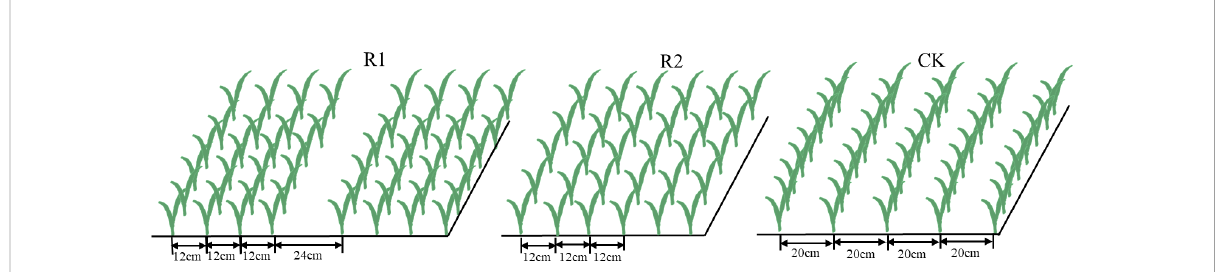
FIGURE 1 Illustration of different row spacings. CK, uniform planting (20 cm); R1, wide-narrow row planting (12 cm-12 cm-12 cm-24 cm); R2, narrow uniform planting (12 cm). Three row spacings used at the same population